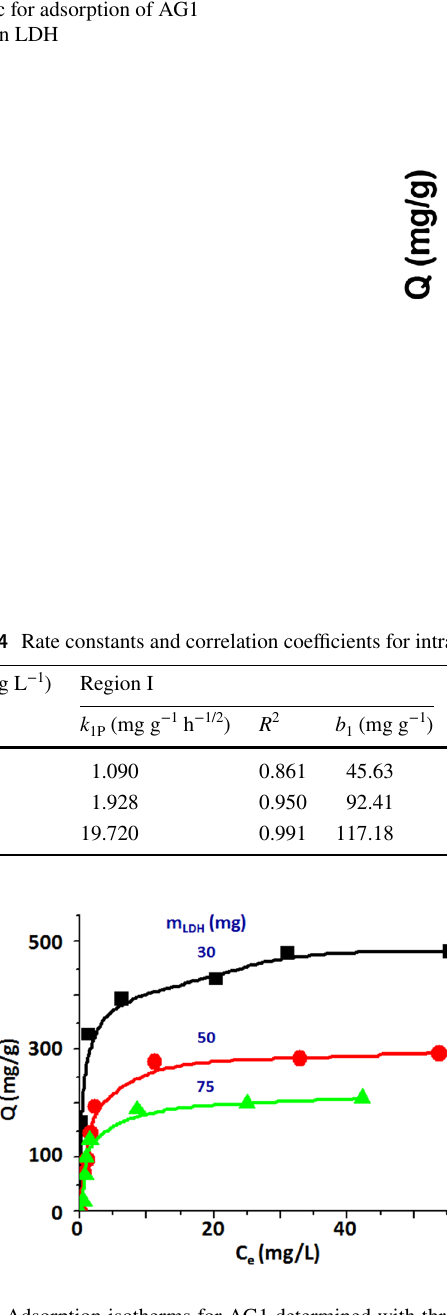
Fig. 5 Intra-particle diffusion kinetic for adsorption of AG1 ions on LDH